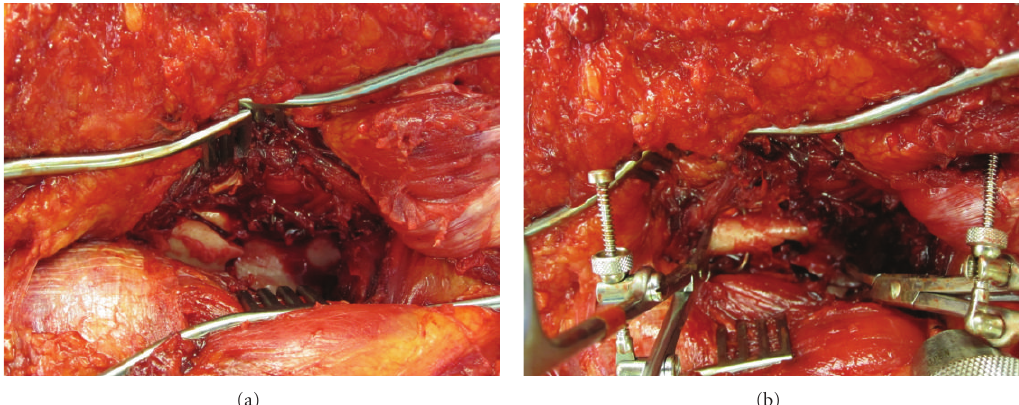
Figure 10: Intraoperative photographs demonstrating the scapular fracture before (a) and after (b) reduction using a 4mm Shantz pin and two point-to-point clamps.